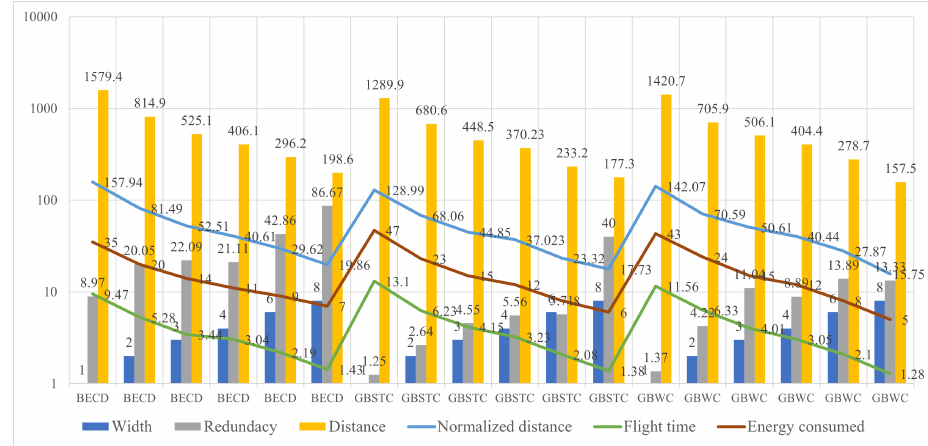
Figure 11. Performance metrics of Typhoon UAV on CSUSL PV plant (Experiment